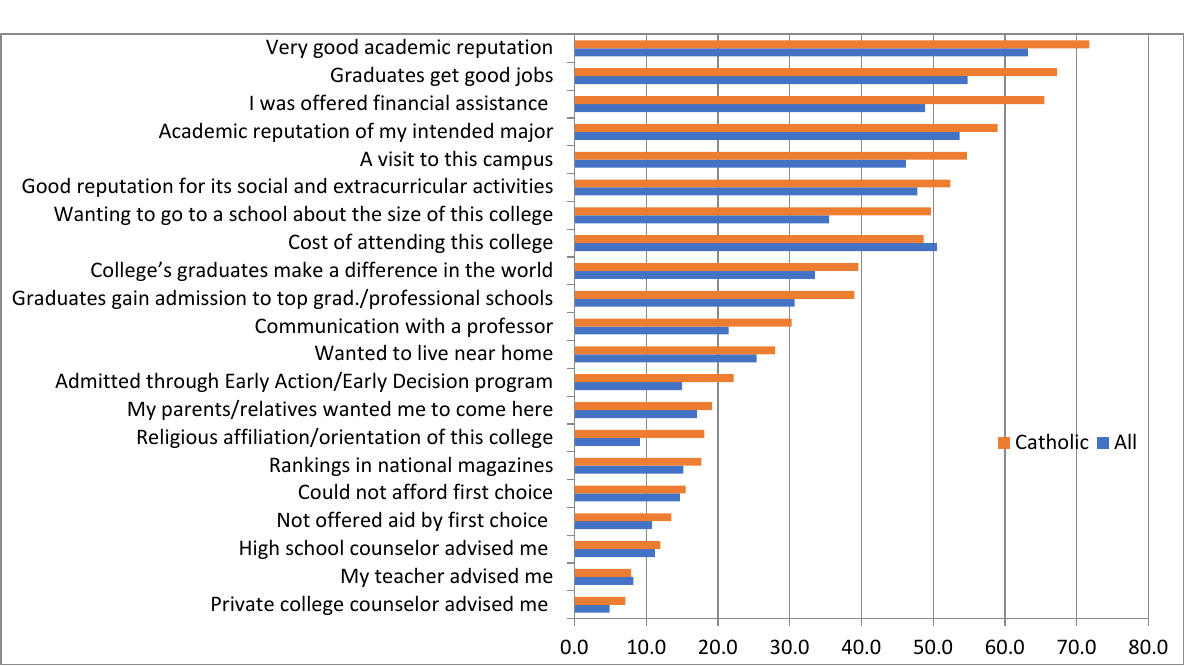
Figure 3. Principal Reasons for Deciding to Go to a Particular College, 2019 (%). Source: Adapted from Stolzenberg et al. (2020).